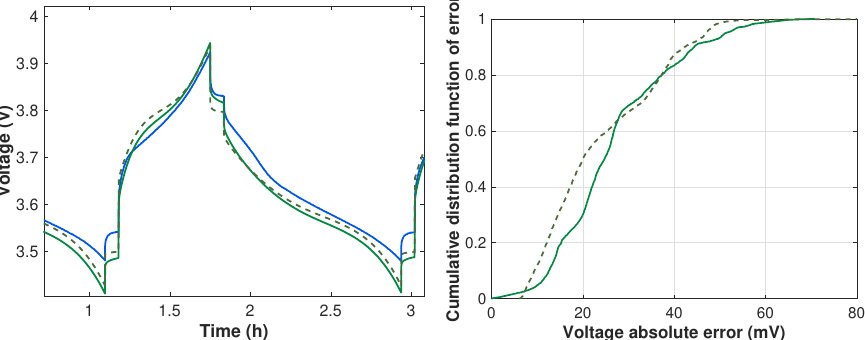
Figure 15. Influence of model choice over accuracy at 25 °C. Left, voltage profile; right error distribu- tion (blue line = measurements, green solid line = CPE model, green dashed line = RC